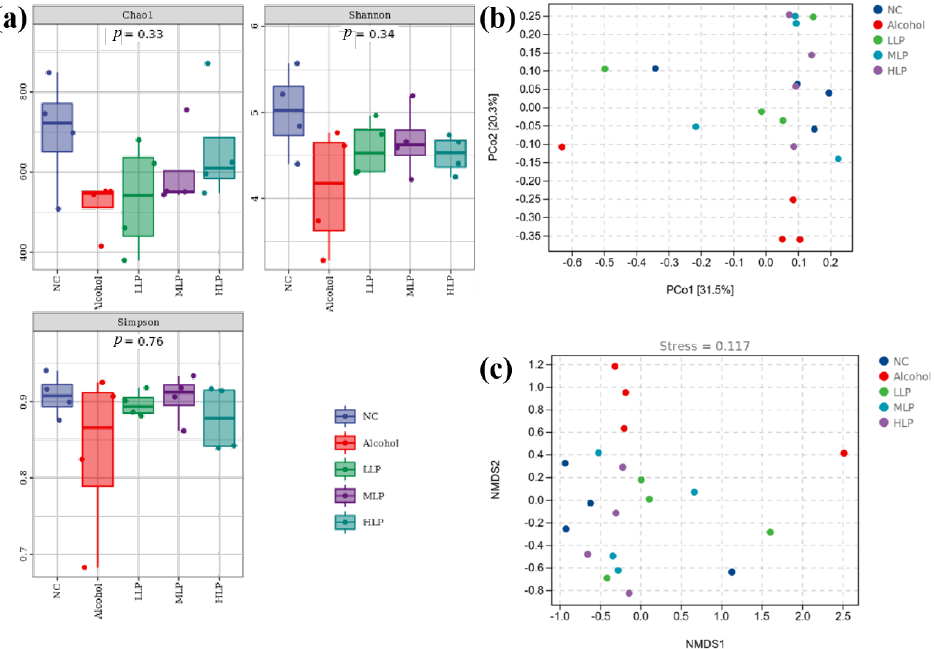
Figure 9. Effects of L. plantarum J26 on Microbial composition. ( a ): Alpha diversity index of intestinal microbiota; ( b ): PCoA analysis of psychrotrophic microbiome among samples; ( c ): NMDS analysis of groups. PCoA, principal coordination analysis; NMDS, non-metric multidimensional scaling; NC, normal control; LLP, low-dose L. plantarum J26; MLP, medium-dose L. plantarum J26; HLP, high-dose L. plantarum J26. The data were expressed as means ± SD ( n = 4).